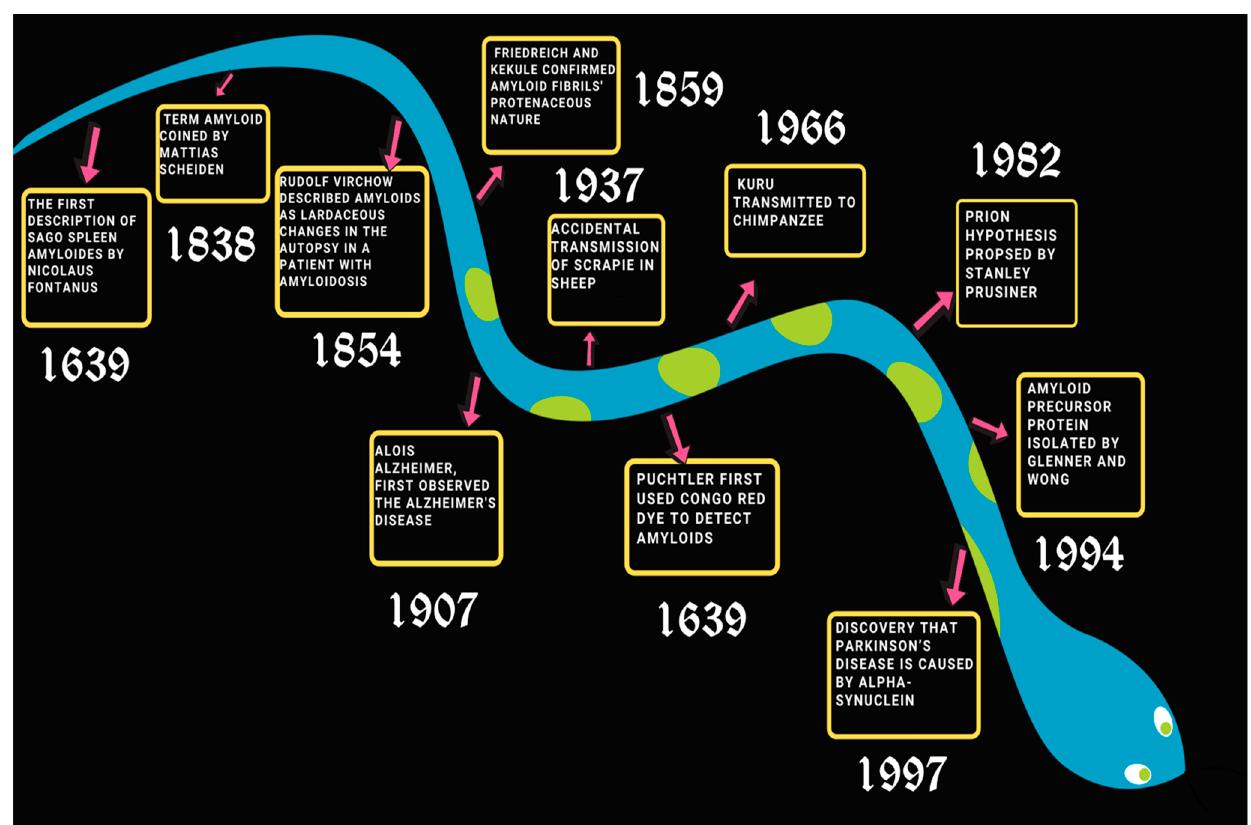
Figure 1. Chronology of events in the history of amyloid research.